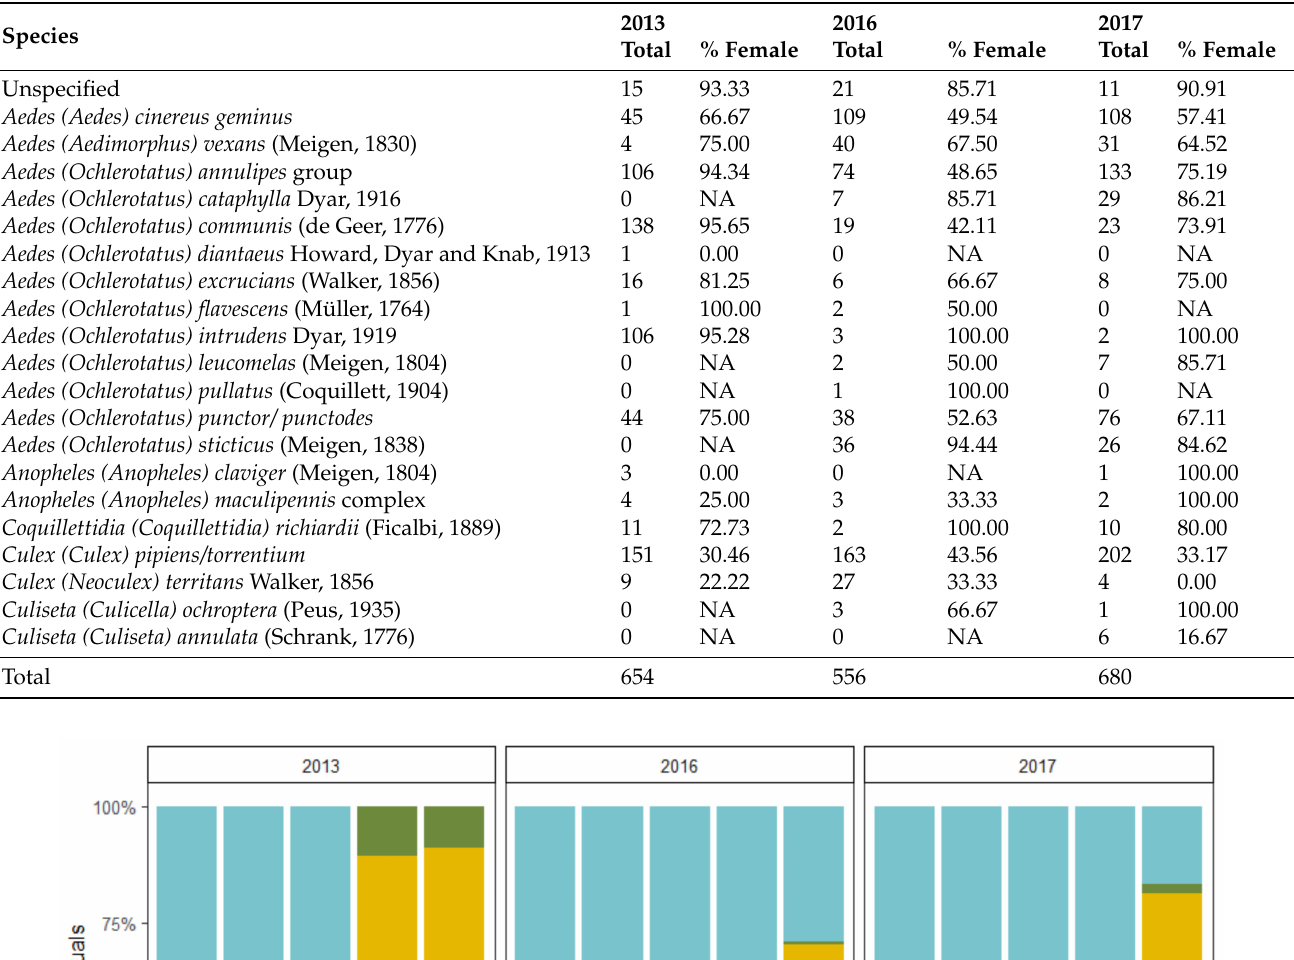
Table 3. List of mosquito species and groups collected during the study in alphabetical order. The table contains the number of individuals from each identified taxon, followed by the percentage (%) of female mosquitoes. Six collection sites were sampled during 2013, seven sites in 2016 and 15 collection points in 2017. The mean number of mosquitoes caught during a collection event was 6.41 in 2013, 3.78 in 2016 and 2.53 in 2017.